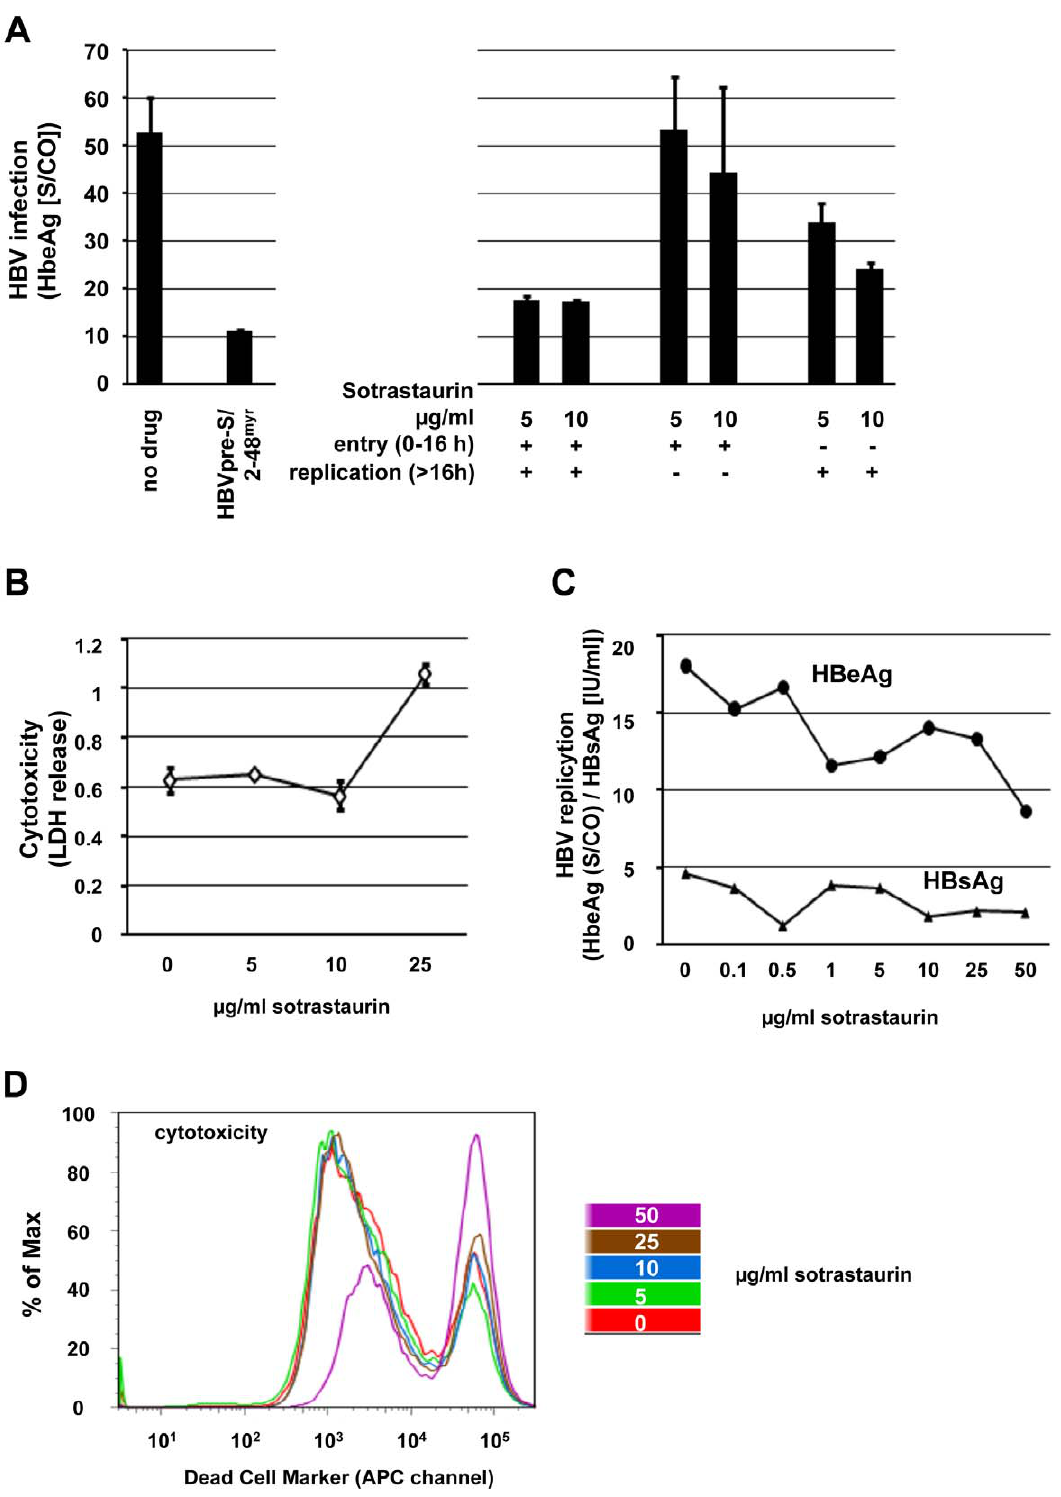
Figure 5: Effects of sotrastaurin on the HBV lifecycle. (A) Differentiated HepaRG cells were infected with HBV virions. Sotrastaurin 5 or 10 m g/ ml was present either during inoculation (initial 16 h), during inoculation and infection (throughout), or after inoculation (from 16 h onwards). An inhibitory fragment from the HBV L-protein (HBV pre-S/2-48my) applied during inoculation served as a positive control. All reactions were adjusted to contain the same final concentration of DMSO. HBeAg levels secreted into the cell culture supernatant were determined at day 9 after infection. (B) Cytotoxic effect of sotrastaurin on differentiated HepaRG cells as measured by and LDH release assay. (C) HBV antigens released from AD38 harboring a replicating HBV genome after 72 hours of sotrastaurin treatment. IU – international units; S/CO - signal to cutoff ratio. (D) AD38 cells were treated with increasing amounts of sotrastaurin. After 72 h cells were stained with a live/dead cell stain kit and analyzed by FACS. doi:10.1371/journal.pone.0024142.g005 PLoS ONE |